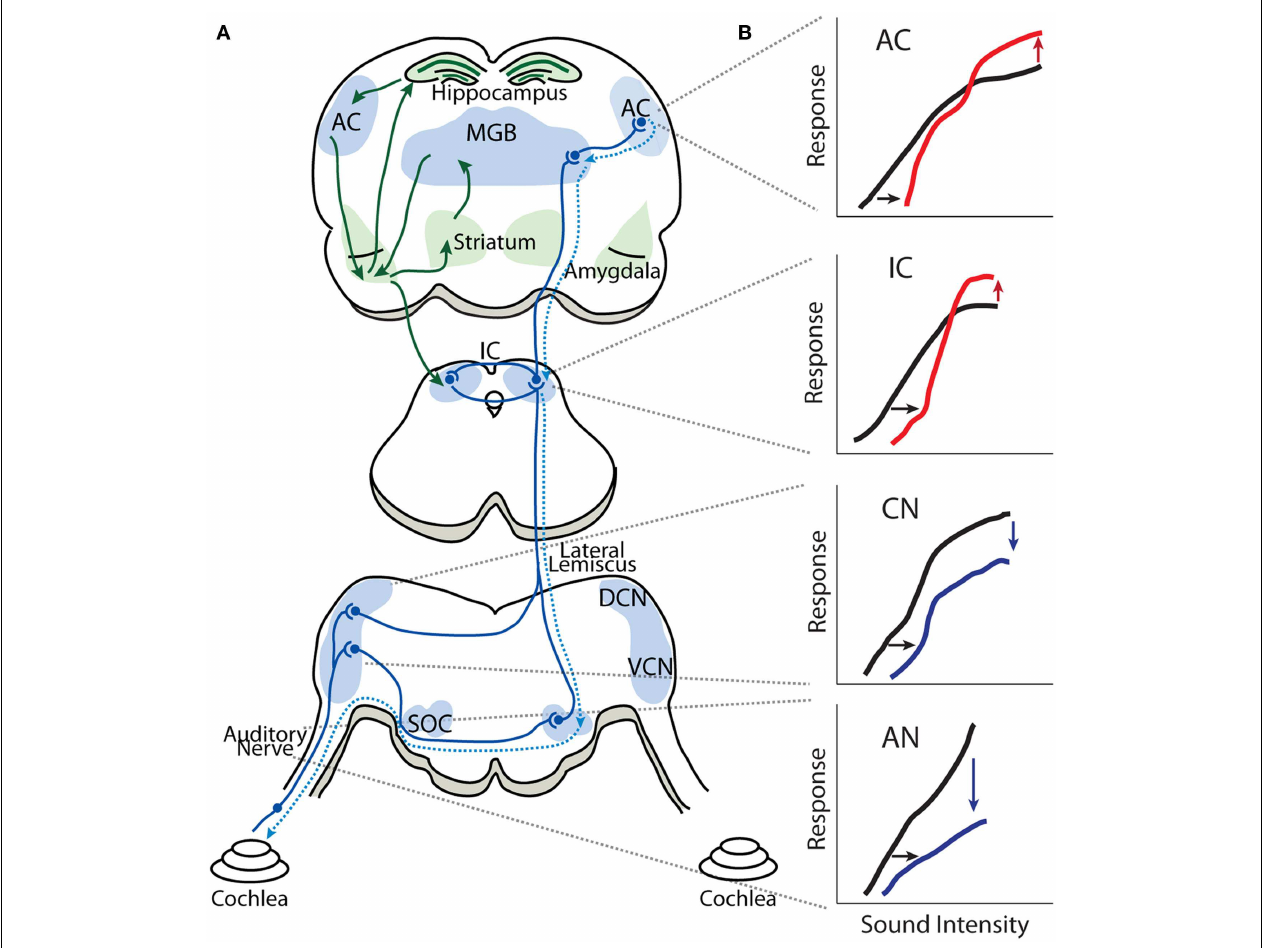
inferior colliculus (IC), and auditory cortex (AC).The black lines represent baseline intensity-level functions. Cochlear damage via noise or ototoxic drug exposure results in depression of sound-evoked responses in lower auditory structures (blue lines) but results in enhancement of suprathreshold responses in higher areas (red lines), despite thresholds being shifted (black arrows). SOC, superior olivary complex;VCN, ventral cochlear nucleus; DCN, dorsal cochlear nucleus; IC, inferior colliculus; MGB, medial geniculate body; AC, auditory